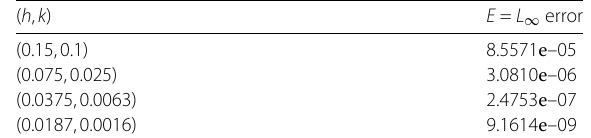
Table 4 Check the validity of Theorem 1 for the European call options under the Merton model: λ = 0, T = 1 and S =